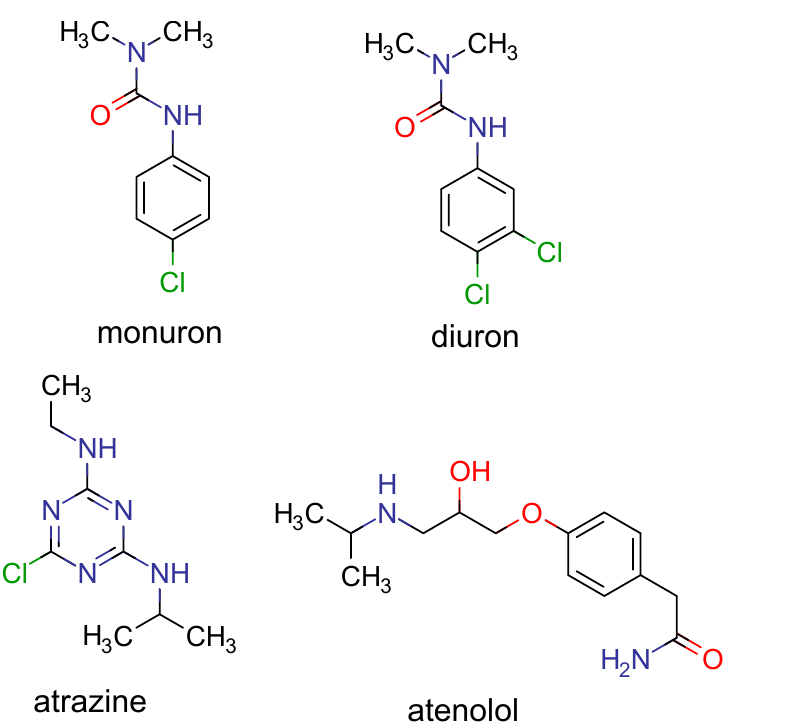
Figure 1. The chemical structure of the studied